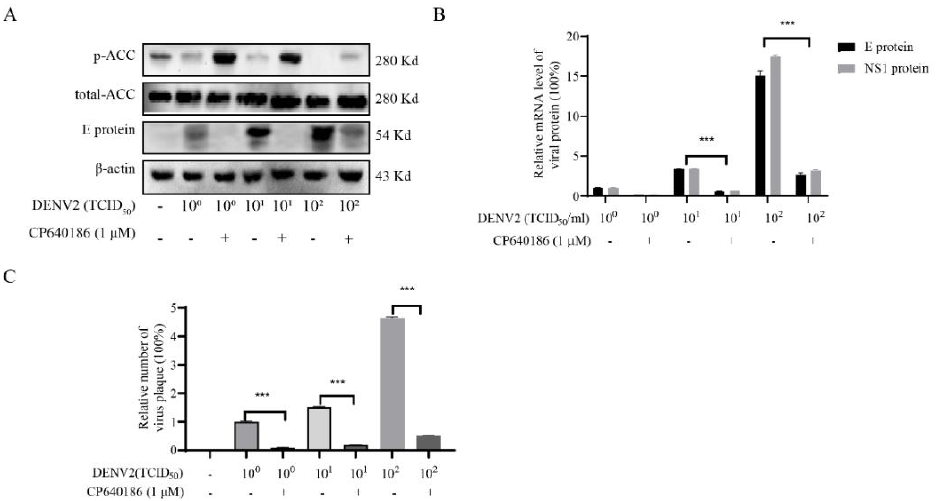
Figure 3. The effect of virus dosage on the antiviral effect of CP640186. After 1 h infection with different dosages of DENV2 (10 0 TCID 50 , 10 1 TCID 50 , and 10 2 TCID 50 ), BHK-21 cells were incubated with CP640186 at 1 µ M for 48 h. ( A ) Then, the protein levels of p-ACC, T-ACC, and E protein were analyzed by Western blotting. ( B ) The mRNA levels of viral E protein and NS3 protein were analyzed by RT-qPCR assay. ( C ) The number of progeny viruses in the supernatant was qualified by plaque assay. Each experiment was repeated 3 times and column data represent mean ± SD. *** indicates p < 0.001.